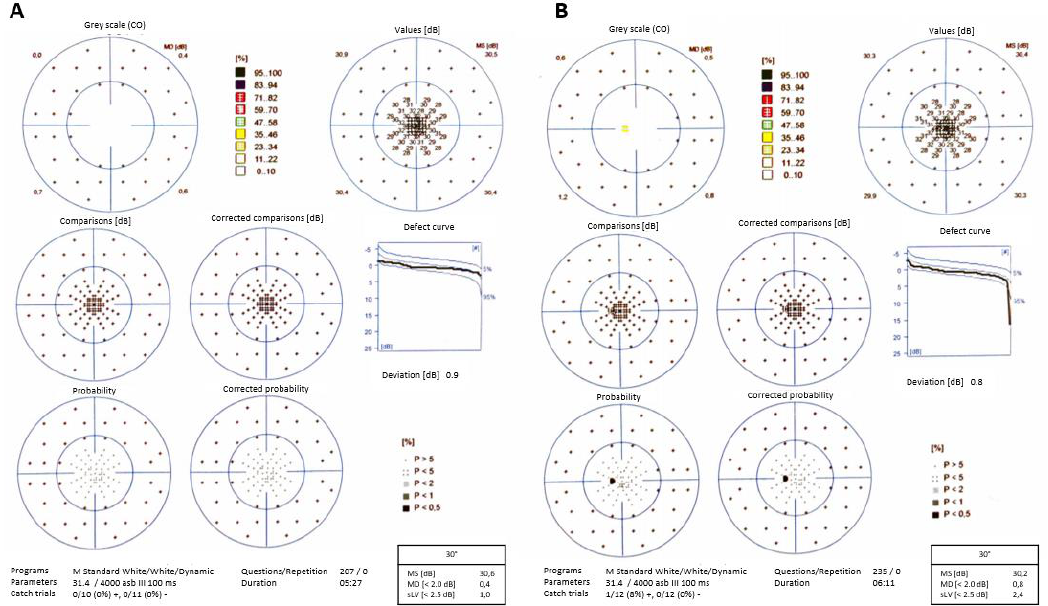
Figure 4. Visual field after 30 months shows disappearance of scotomas in right eye ( A ) and a residual paracentral scotoma in left eye ( B ).